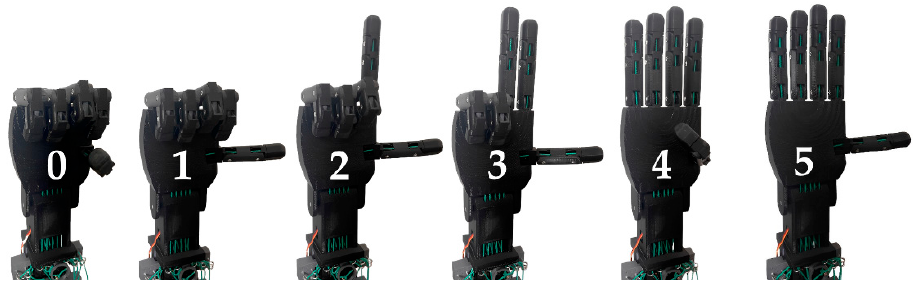
Figure 10. Finger counting sequence on hand prosthesis from 0 to 5.